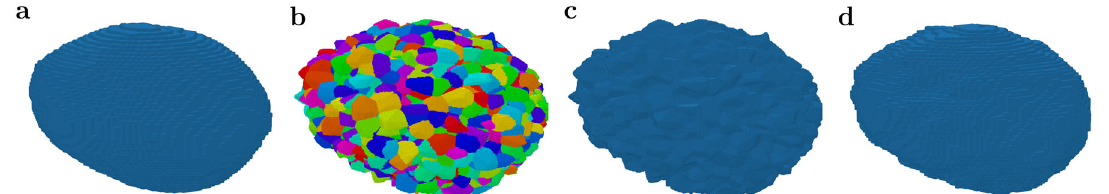
Fig. 8 Visual validation of the multi-scale model. Discretized realization of the outer shell model { X ( u ): u 2 S 2 } ( a ), the corresponding realization of the multi-scale model ( b ). The discretized outer shell of the realization of the multi-scale model is depicted in ( c ). In ( d ) the outer shell depicted in ( c ) is visualized after applying the same degree of smoothing as for the CT data.